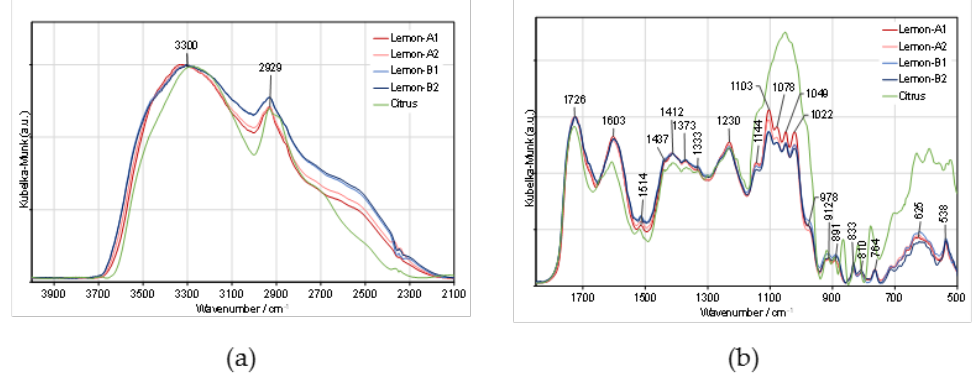
Figure 7. Comparison of the DRIFT spectra of lemon IntegroPectin (Lemon-A and Lemon-B) and − 1 and ( b ) 200–950 cm − 1 spectral commercial (Citrus) pectin: ( a ) 4000 – 2100 cm −1 and ( b ) 200 – 950 cm −1 spectral regions. commercial (Citrus) pectin: ( a ) 4000–2100 cm